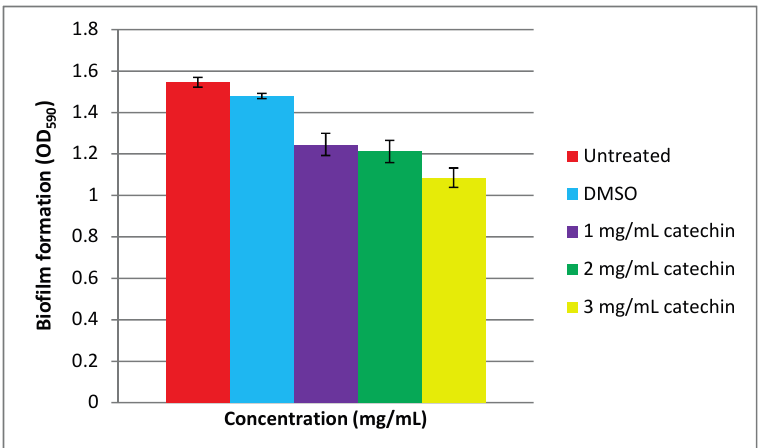
Figure 4. Biofilm formation in Vibrio sp. strain T33. Qualitative analyses of biofilm formation and inhibition by catechin. Bars represent standard errors of the